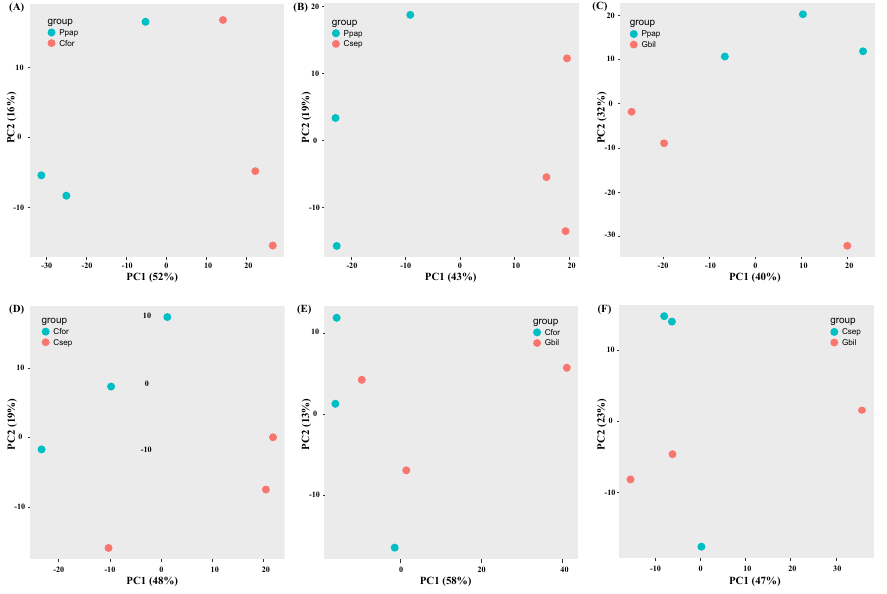
Figure 3. PCA analysis of each comparison. ( A ) Represented Bpap vs. Cfor comparison. ( B ) Represented Bpap vs. Csep comparison. ( C ) Represented Bpap vs. Gbil comparison. ( D ) Represented Cfor vs. Csep comparison. ( E ) Represented Cfor vs. Gbil comparison. ( F ) Represented Csep vs. Gbil